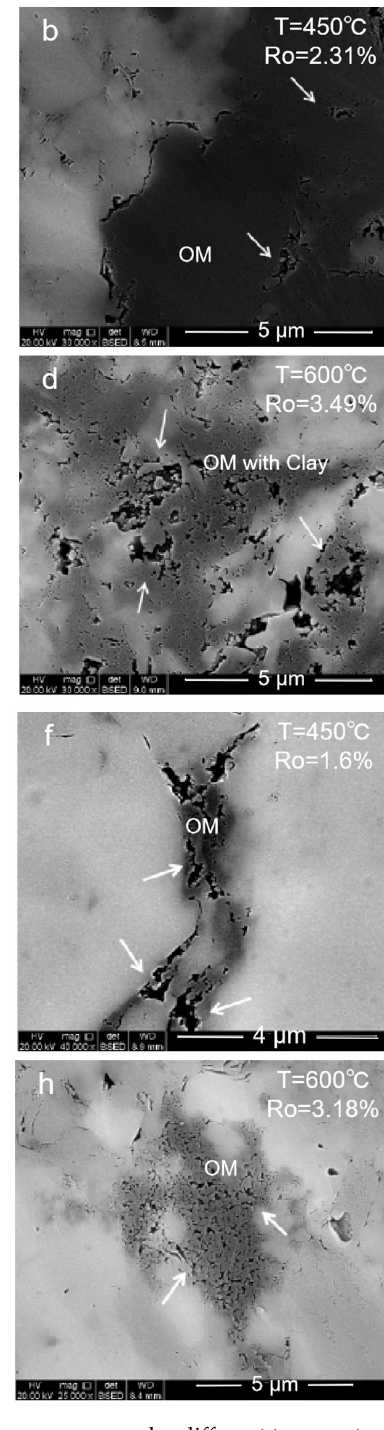
Figure 3. Evolution of the organic pores in the two groups under different temperatures. ( a ) Group 1, semiclosed system, T = 400 °C, organic matter begins to crack, bitumen fills the original pores. ( b ) Group 1, semiclosed system, T = 450 °C, organic pores further develop and enlarge. ( c ) Group 1, semiclosed system, T = 500 °C, a large number of shrinkage seams develop inside the organic matter. ( d ) Group 1, semiclosed system, T = 600 °C, the organic pores expand, connect, and decompose the organic matter framework. ( e ) Group 2, open system, T = 400 °C, a few organic pores are developed. ( f ) Group 2, open system, T = 450 °C, edge cracks and shrinkage cracks develop in the organic matter. ( g ) Group 2, open system, T = 500 °C, the shrinkage seams develop inside the organic matter. ( h ) Group 2, open system, T = 600 °C, organic pores are developed.